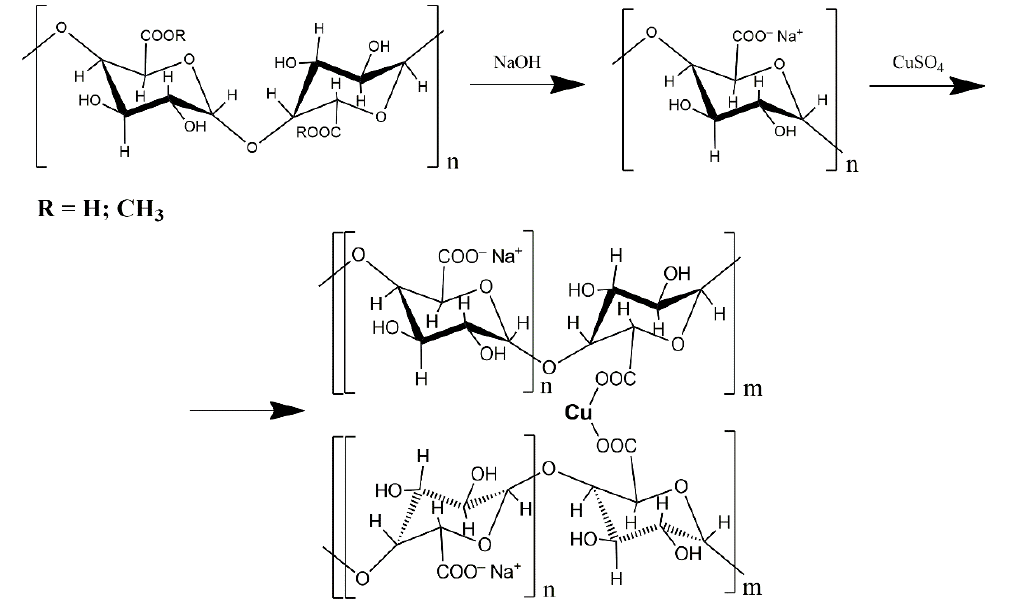
Figure 2. Synthesis of the sodium pectate complex with copper.